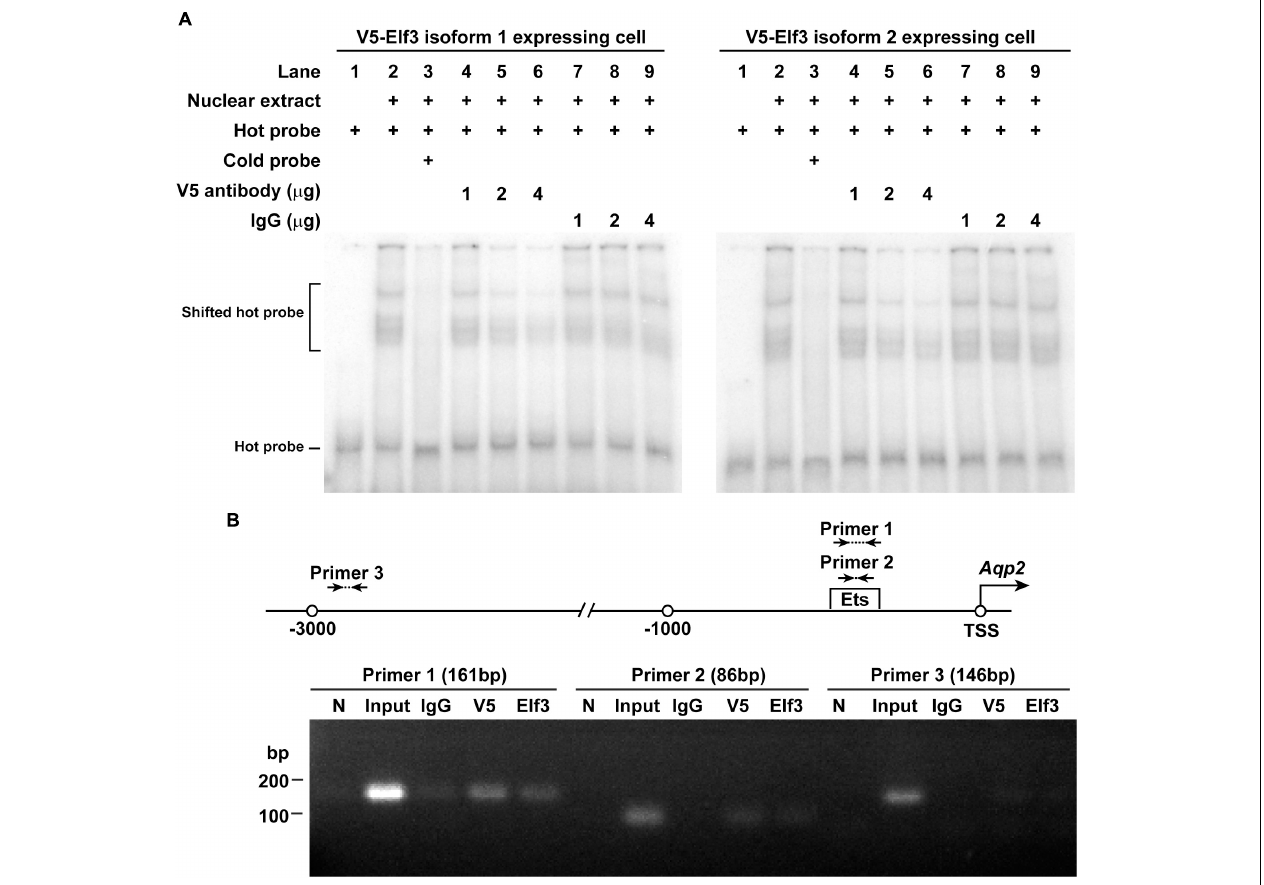
FIGURE 5 | Elf3 bound the Ets element in the AQP2 promoter in the mpkCCD cells. (A) Electrophoretic mobility shift assay. Nuclear extract from either V5-tagged Elf3 isoform 1 (left panel) or V5-tagged Elf3 isoform 2 (right panel) expressing mpkCCD cells was incubated with a 32 P isotope-labeled AQP2 promoter DNA (hot probe) and subjected to electrophoresis followed by autoradiography. A non-isotope labeled competitor AQP2 promoter DNA (cold probe) or a V5 antibody (at 1, 2, or 4 µ g) was used to inhibit the interaction. A non-specific IgG was used as a control. (B) ChIP-PCR assay. Chromatin immunoprecipitation was done with a control (IgG), V5 tag, or Elf3 antibody before PCR analysis with primer sets framing the indicated regions in the AQP2 promoter. N is a no template negative PCR